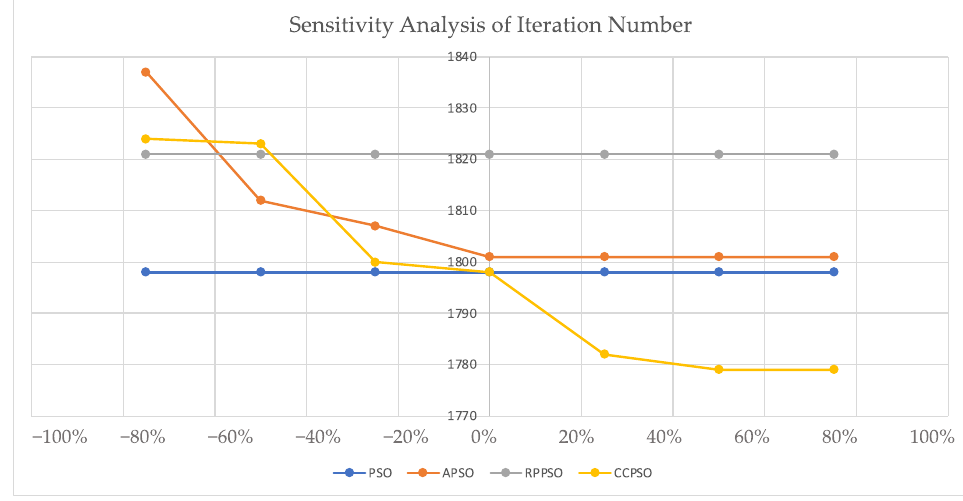
Figure 13. Sensitivity analysis of iteration number.